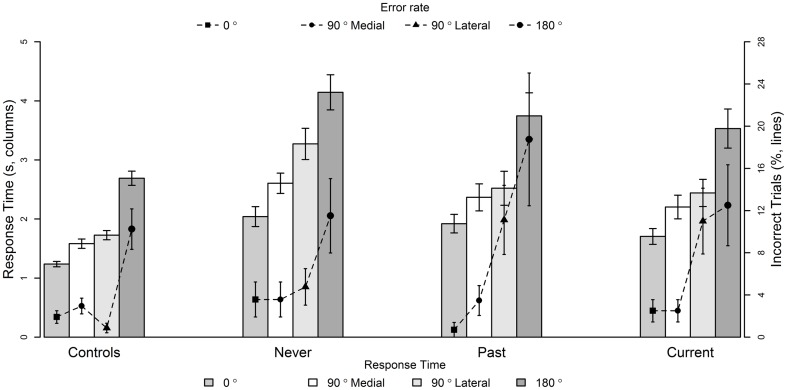
Mean response times (seconds, columns) and inaccuracy (%, lines) of hand laterality judgments at 0°, 90° Medial, 90° Lateral, and 180° rotations for Controls, people with no history of passivity symptoms (Never), people with a past history of passivity symptoms (Past), and people with current experiences of passivity symptoms (Current). Data are mean ± SEM. See text for treatment contrasts.